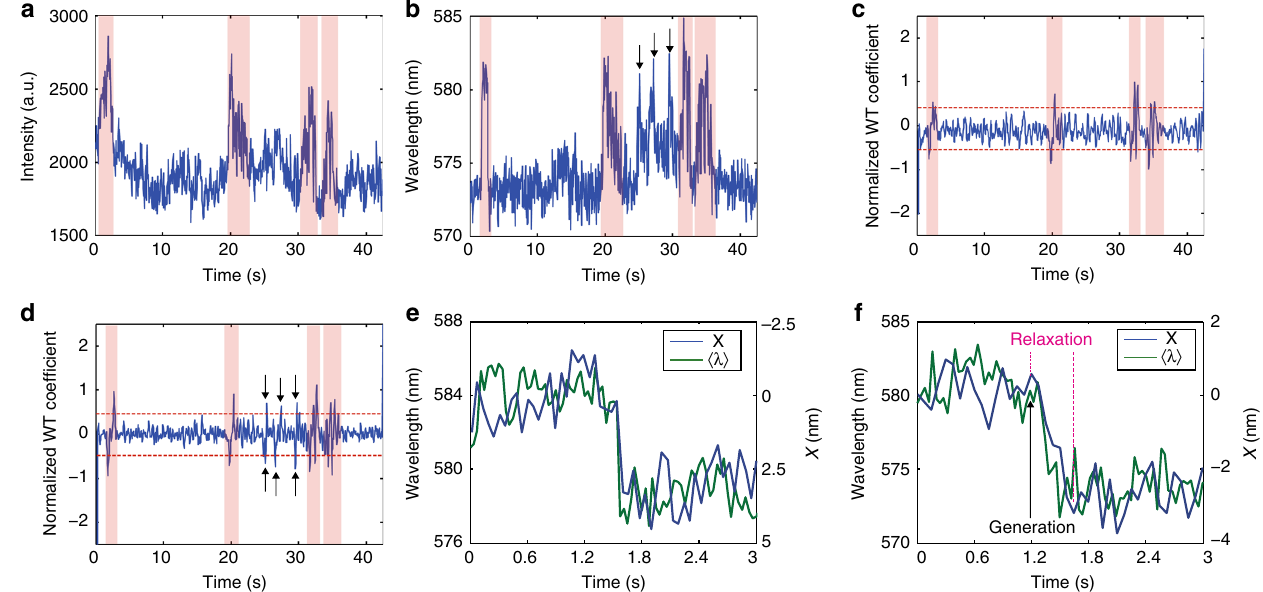
Fig. 2 Change point analysis of single-particle intensity and spectrum centroid trajectories. a A single-particle fl uorescence intensity trajectory showing two-level blinking behavior. b The corresponding spectrum centroid trajectory. c , d Haar wavelet transform coef fi cient trajectories of the intensity trajectory ( c ) and the spectrum centroid trajectory ( d ). The peaks in the wavelet transform coef fi cient trajectories indicate change points in the original trajectories (thresholds to differentiate local maximum from noise are shown by the red dashed lines). The red bands indicate the spectrum shifts that are correlated with the blinking events. The black arrows indicate the spectrum change points that are uncorrelated with the blinking dynamics. e The X position trajectory of the fl uorescence centroid of a CPN (blue) and the corresponding spectrum centroid trajectory (green), showing a discrete jump during the polaron generation process. f The X position trajectory of the fl uorescence centroid of a CPN (blue) and the corresponding spectrum centroid trajectory (green), showing continuous drift during the polaron generation